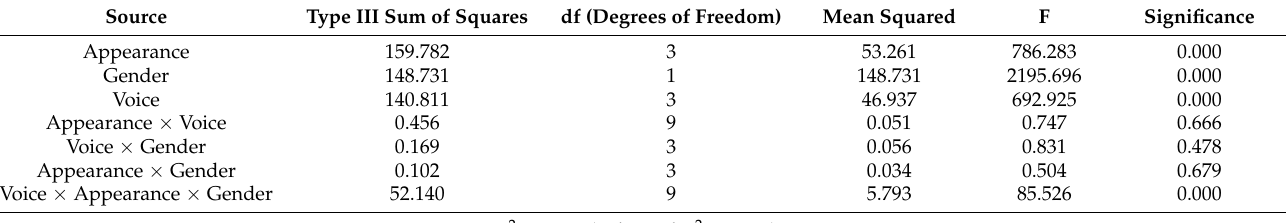
Table 1. Interaction terms among voice, gender, and